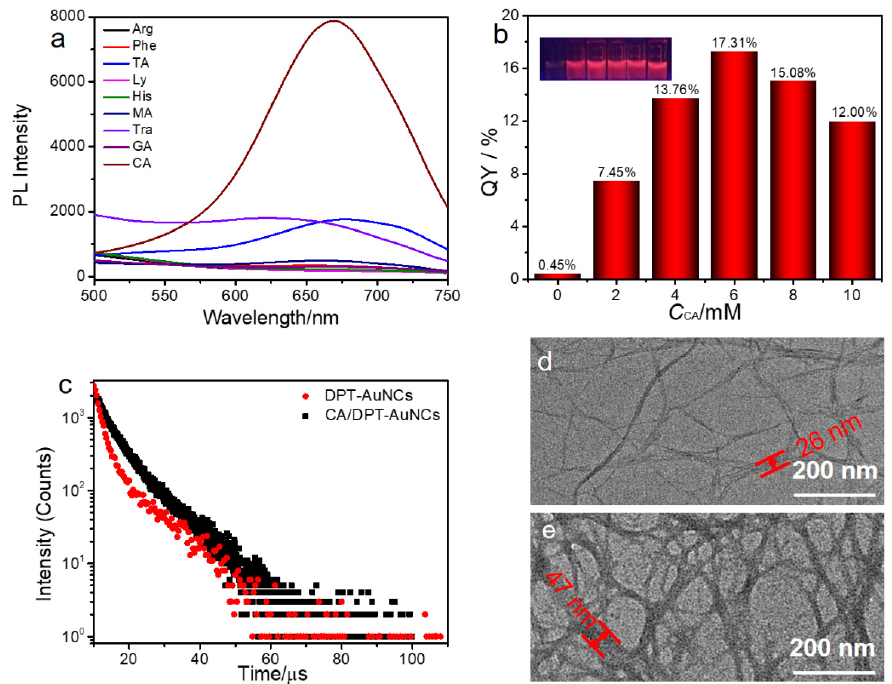
Figure 1. ( a ) PL spectra of DPT-AuNCs with different small molecules added (CA, TA, Tra, Phe, Ly, GA, Arg, His and MA, c small molecules = 6 mM, λ ex = 390 nm). ( b ) QY of DPT-AuNCs with different concentrations of CA (insets are photos of samples under handhold UV lamps with 365 nm). ( c ) PL decay curves of DPT-AuNCs and CA/DPT-AuNCs, c CA = 6 mM. ( d ) TEM images of DPT-AuNCs. ( e ) TEM images of CA/DPT-AuNCs ( c CA = 6 mM).